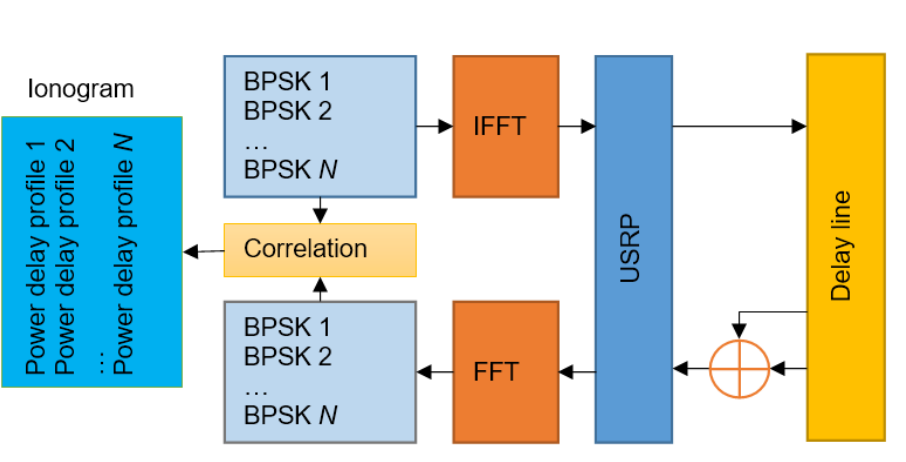
Fig. 7. Block scheme of the laboratory prototype of the OFDM